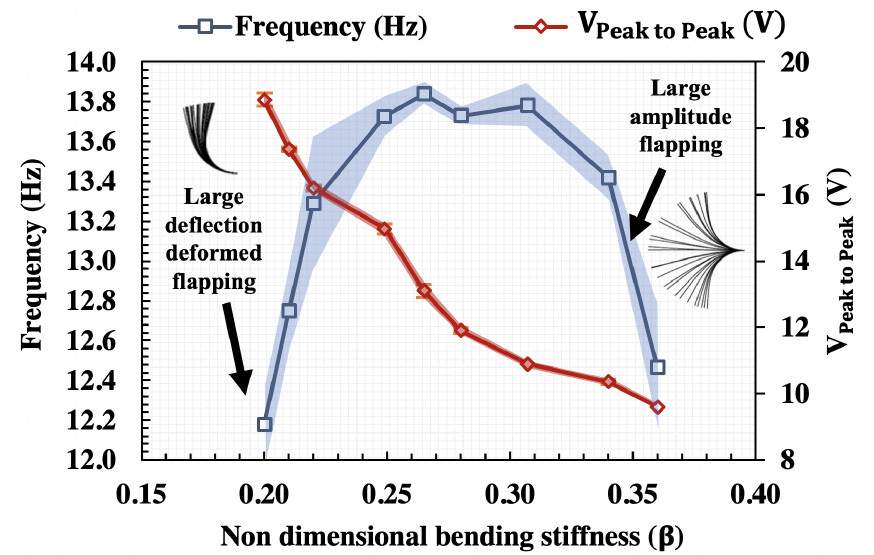
Figure 22. Variation of PVDF-Polymer frequency and peak-to-peak voltage output from PVDF-Polymer combination as a function of non-dimensional bending stiffness β . The variation in the frequency and amplitude matches the trends shown in Figure